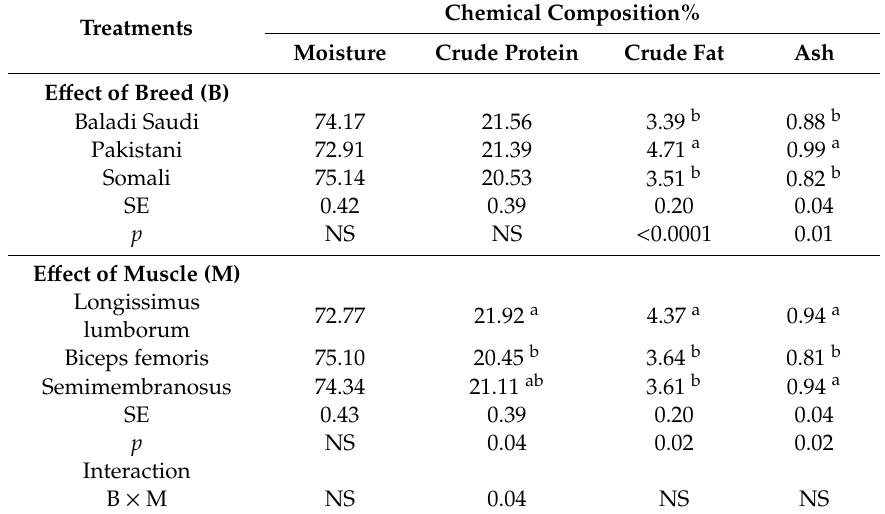
Table 1. E ff ect of breed and muscle type on chemical composition of camel meat (n = 24 / breed). Chemical Composition% Treatments Moisture Crude Protein Crude Fat Ash E ff ect of Breed (B) Baladi Saudi